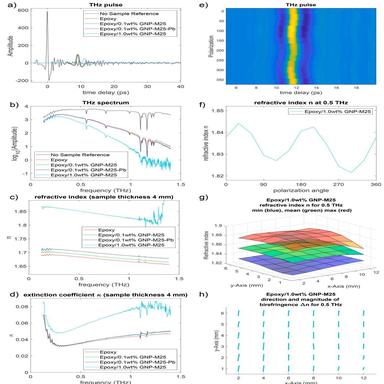
Terahertz spectroscopy: THz pulses (a), THz spectra (b), refractive indices (c) and extinction coefficients (d) for different epoxy samples; birefringent properties as time delay vs. the polarization angle (e), and as refractive index vs. the polarization angle (f), for Epoxy/1.0 wt% GNP-M25 sample; spatial variation of refractive index (g) and direction of birefringence (h).